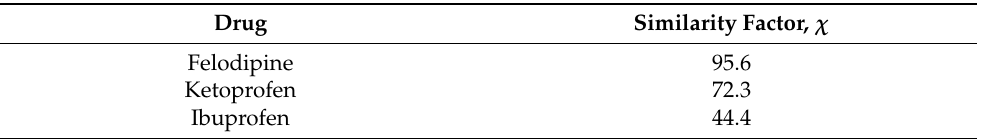
Table 4. Comparison of the similarity factors between the release profiles from HKUST-1 and HKUST- 1/10% GO